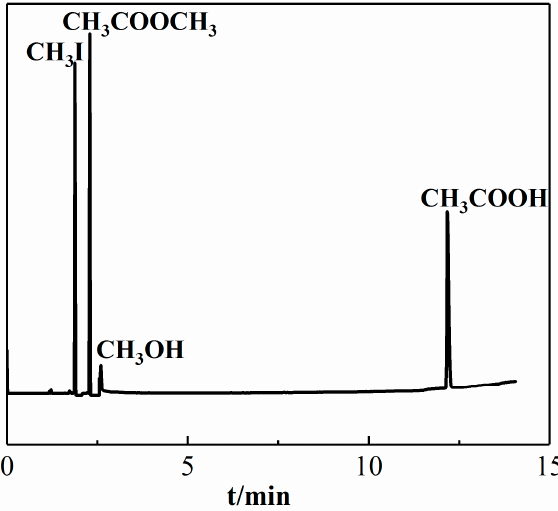
Figure 1. GC-MS diagram of carbonylation reaction product.